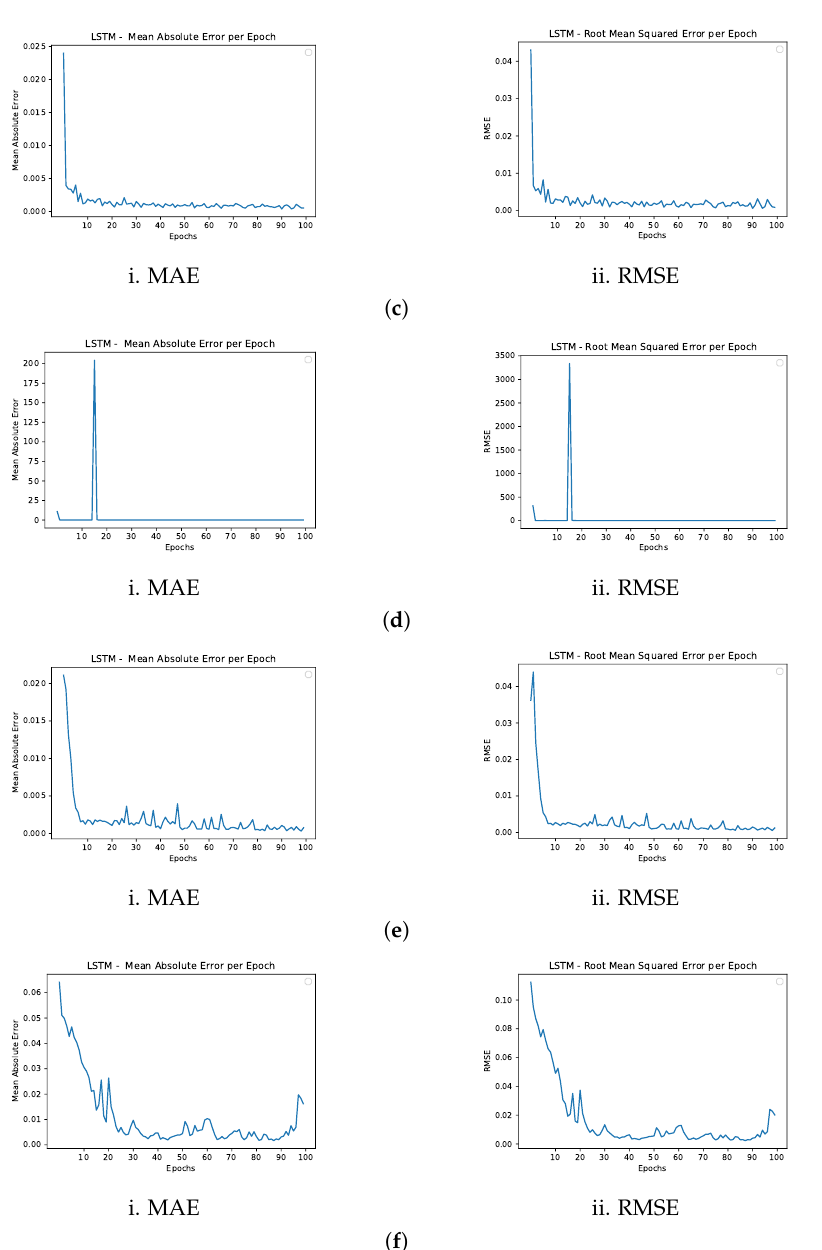
Figure 11. Metrics for the LSTM Model. ( a ) Error Metrics for ANL-Intrepid-2009-1 Dataset. ( b ) Error Metrics for CEA-Curie-2011-2 Dataset. ( c ) Error Metrics for CIEMAT-Euler-2008-1 Dataset. ( d ) Error Metrics for KIT-FH2-2016-1 Dataset. ( e ) Error Metrics for METACENTRUM-2013-3 Dataset. ( f ) Error Metrics for UniLu-Gaia-2014-2 Dataset.